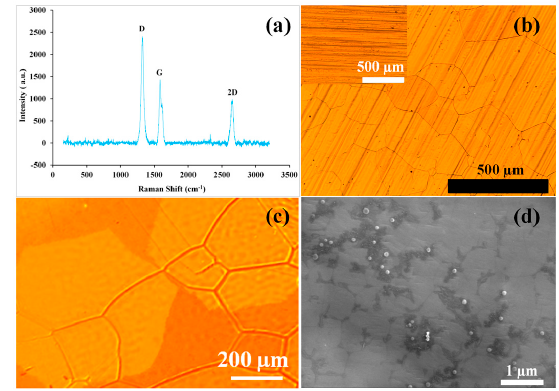
Figure 2. Graphene coated copper ( a ) Raman spectrum; ( b ) optical micrograph of graphene (inset, bare copper) in this study; ( c ) optical micrograph (from [35]) showing copper grain boundaries underneath the hexagonal graphene grains (Reprinted with permission from T. Wu, G. Ding, H.